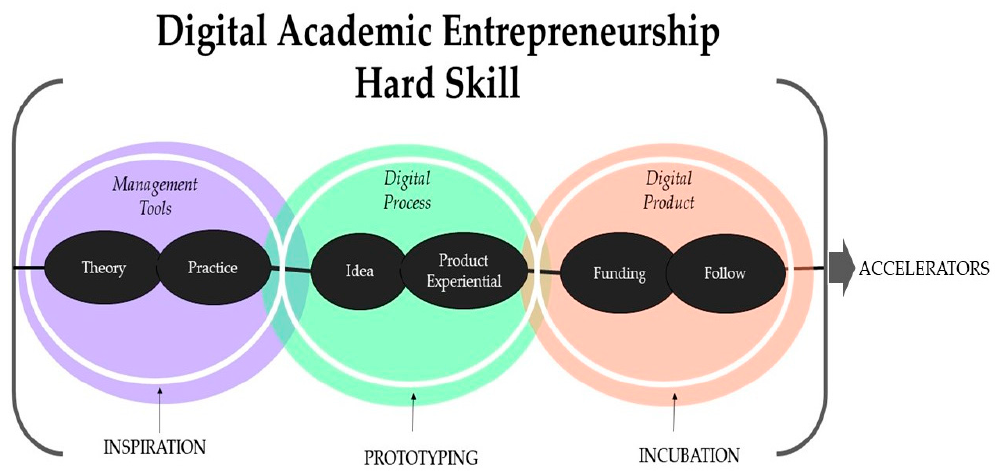
Figure 3. Framework